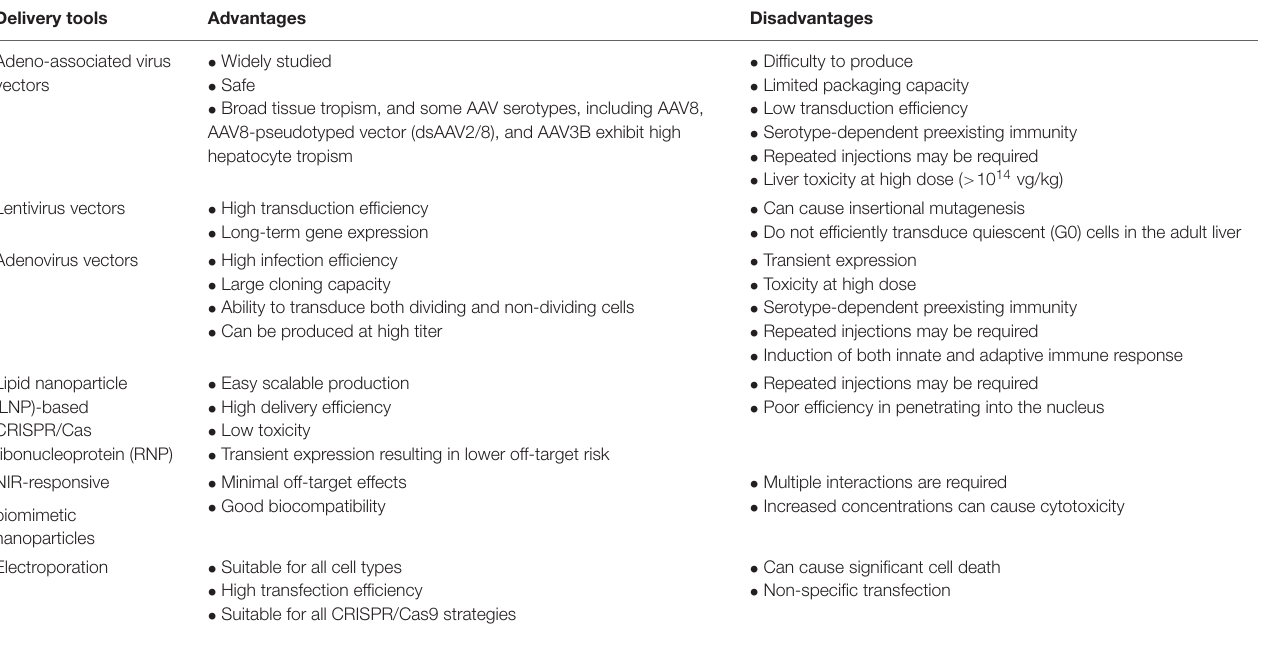
TABLE 1 | Advantages and disadvantages of the various delivery tools used for CRISPR/Cas9